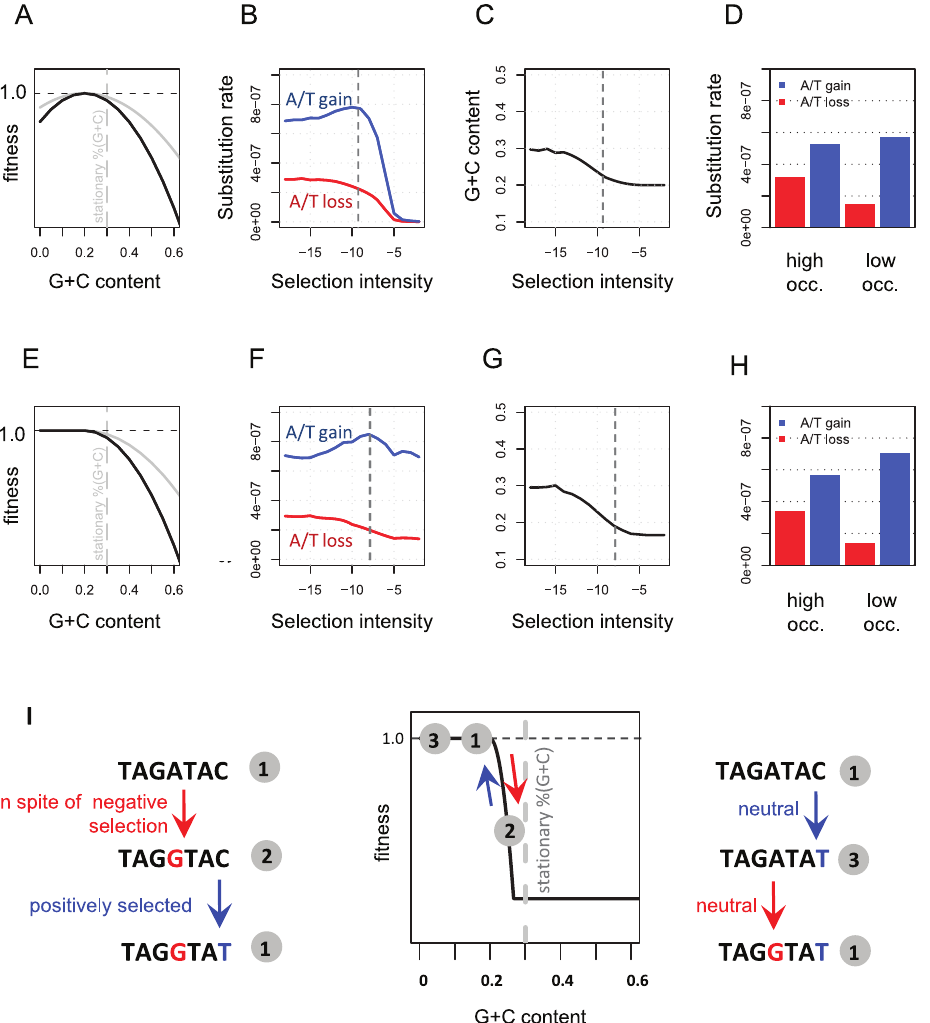
Figure 5. A model of weak compensatory selection predicts the evolutionary dynamics at yeast low occupancy sequences. We simulated the evolution of a fixed size population of small (20 bp) ‘‘genomes’’ in simple fitness landscapes that depend only on the G + C content of the sequence (Methods). We used a mutational input that favors A/T over G/C, resulting in a neutral stationary G + C content of 30%. A ) G + C goal fitness landscape. Shown are fitness landscapes (fitness value as a function of the G + C content) preferring low G + C content (the ‘‘low occupancy’’ regime). We generated regimes with different selection intensities (denoted by g ) by changing the slope of the depicted parabola (shown are the landscapes for two different intensities). B ) Substitution rates. Shown are substitution rates of A/T loss (red) and A/T gain (blue) measured in populations evolving under different levels of selection intensities (X axis) in the low G + C content fitness landscape. We note the increase in A/T gain rate to values higher than neutral at intermediate selection intensities. C ) Stationary G + C content. Shown are the population average G + C contents for population evolving in different selection intensities (X-axis), showing that at intermediate levels of selection where A/T gain rate were elevated (dashed line), the average G/C content is only slightly higher than the optimum. D ) Substitution rates for intermediate selection intensity. We summarize the simulation by showing substitution rates for a specific level of selection intensity (marked in dashed lines in B and C). Data is shown for the low G + C fitness landscape and for a high G + C fitness landscape that was defined symmetrically with a preferred G + C content of 40% ( Fig S8 ). The data are generally compatible with our empirical observations on yeast divergence rates ( Fig 2C, 4C ). E–H ) Evolutionary dynamics for a threshold fitness landscape. An analysis similar to the above, but with a threshold-function fitness landscape (E) reveals that an increase in A/T gaining substitution rates can be observed over a wide range of fitness intensities. I ) Compensatory evolution explains the increase in A/T gaining substitution rates. According to our model, the evolution of low occupancy sequences is attempting to maintain low G + C content in spite of a flux of slightly deleterious mutations that pushes toward a higher stationary G + C content. Selection may not be sufficiently powerful to purge every deviation from the optimum and mutations that decrease A/T content may persist (even partially) in the population. These mutations trigger adaptive evolution of corrective mutations, which is efficient since it can occur at multiple positions. The schematic shown here assumes evolution in the threshold fitness landscape (E–H), in which A/T gaining substitutions are never deleterious and therefore robustly increased in rate even if selection is intensive. A variation of the same argument shows why A/T gain rate increases in the fitness landscape of A–D.